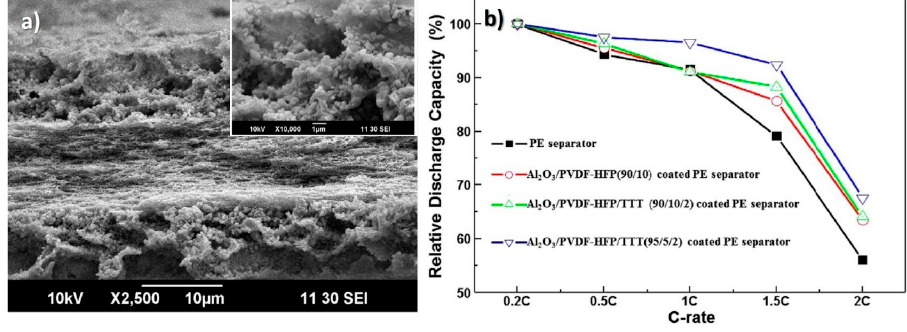
Figure 5. ( a ) Cross ‐ section scanning electron microscopy (SEM) images of the γ‐ Al 2 O 3 /PVDF